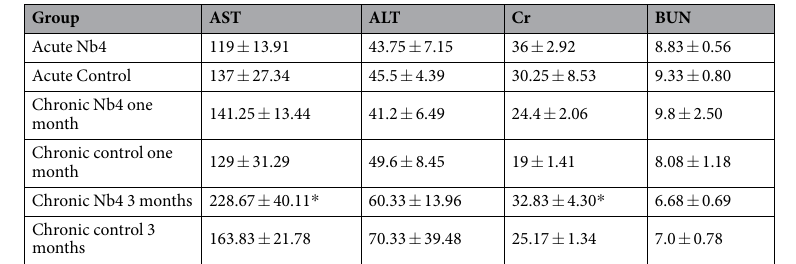
Group AST ALT Cr BUN Acute Nb4